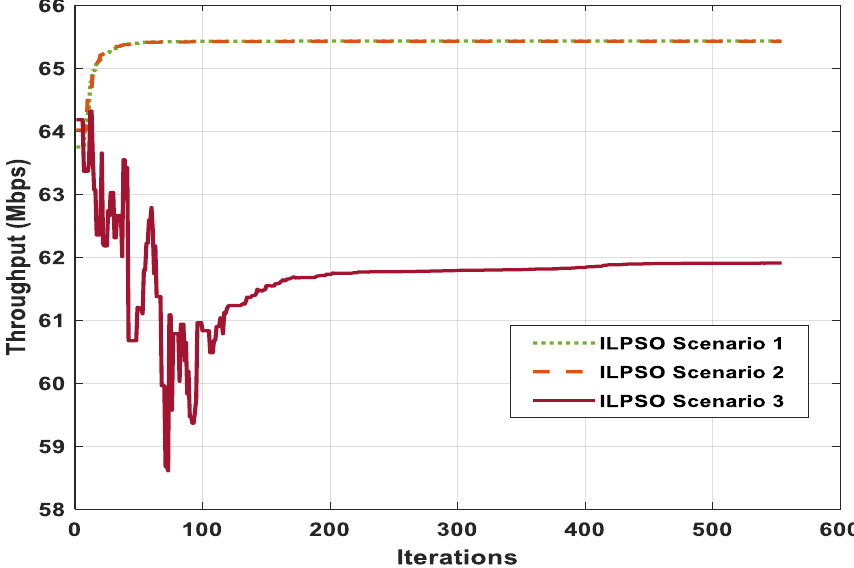
Figure 5. Algorithm convergence vs. achieved throughput.